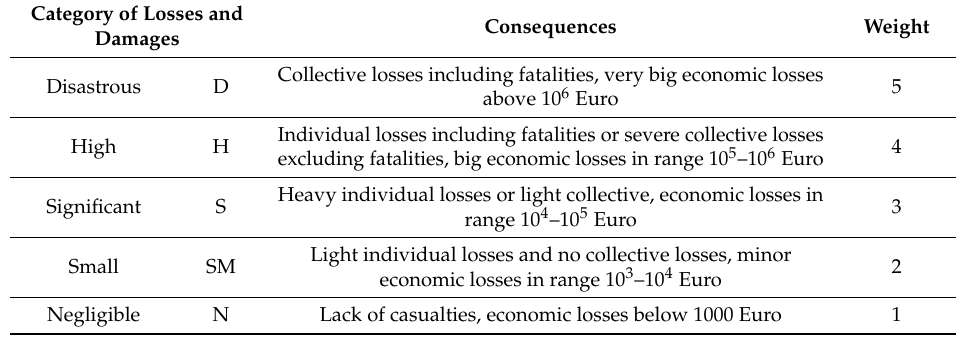
Table 5. Scale of losses and damages.